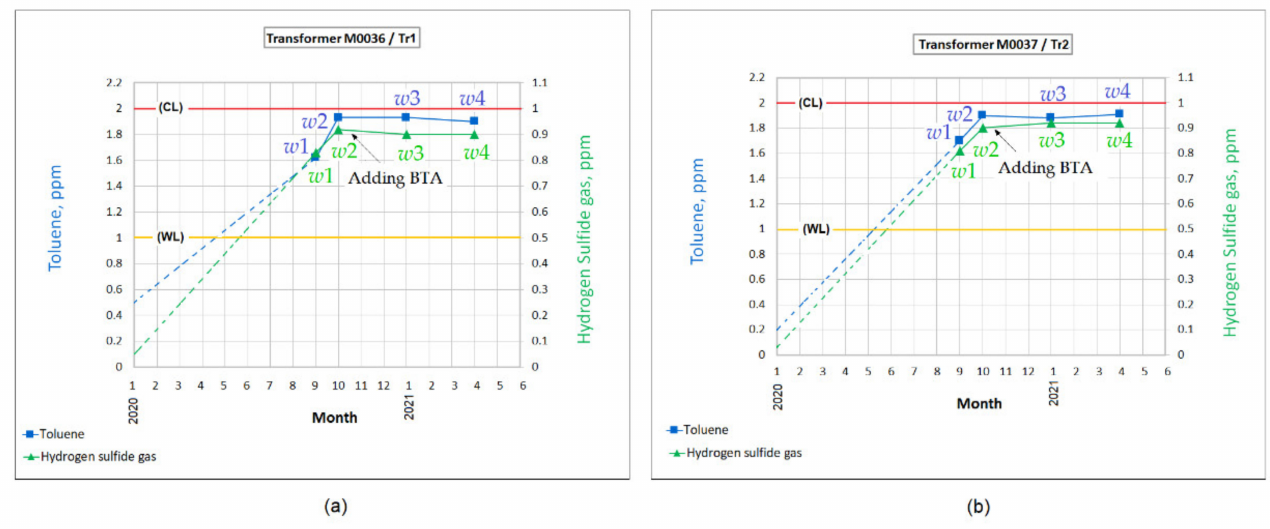
Figure 5. Fault trend charts of ( a ) Transformer 5 (M0036/Tr1) and ( b ) Transformer 6 (M0037/Tr2). CL = Caution limit, WL = Warning limit, w 1 = first measured value, w 2 = second measured value after one month, w 3 and w 4 = measured values after adding